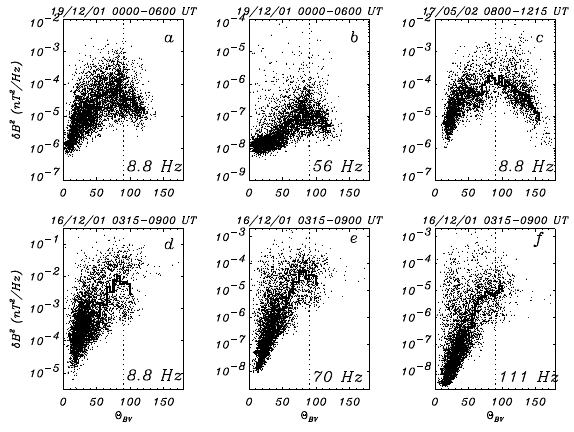
2 Figure1:S atterplotsofthetra e δB ofthespe tralmatrixofthemagneti B Fig. 1. Scatter plots of the trace δB 2 of the spectral matrix (cid:29)u tuationsevery4s,asafun tionoftheangle Θ BV betweenthe (cid:28)eldandthe V (cid:29)owvelo ity inthemagnetosheath:a)day19/12/2001,for f =8.8Hz;b) of the magnetic fluctuations every 4s, as a function of the angle 19/12/2001, f =56Hz; )17/05/2002,8.8Hz;d)16/12/2001,8.8Hz;e) 16/12/2001,70Hz;f)16/12/2001,111Hz.Thethi klinegivesthemedianvalue ◦ 2 BV between the B field and the flow velocity V in the mag- forbins 5 wide.1 netosheath: (a) 19 December 2001, for f =8.8Hz; (b) 19 Decem- ber 2001, f =56Hz; (c) 17 May 2002, 8.8Hz; (d) 16 December 2001, 8.8Hz; (e) 16 December 2001, 70Hz; (f) 16 December 2001, 111Hz. The thick line gives the median value for bins 5 ◦ wide.